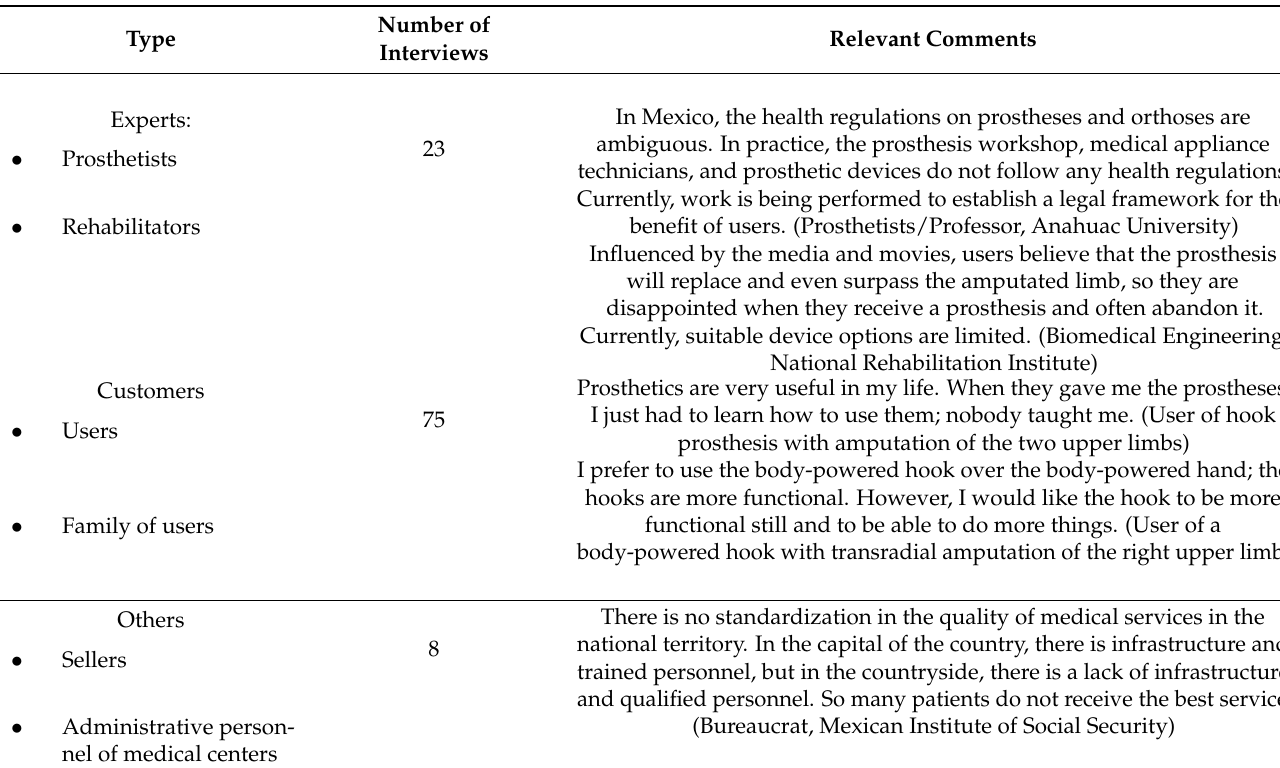
Table 1. Interviews with prosthetic users and related